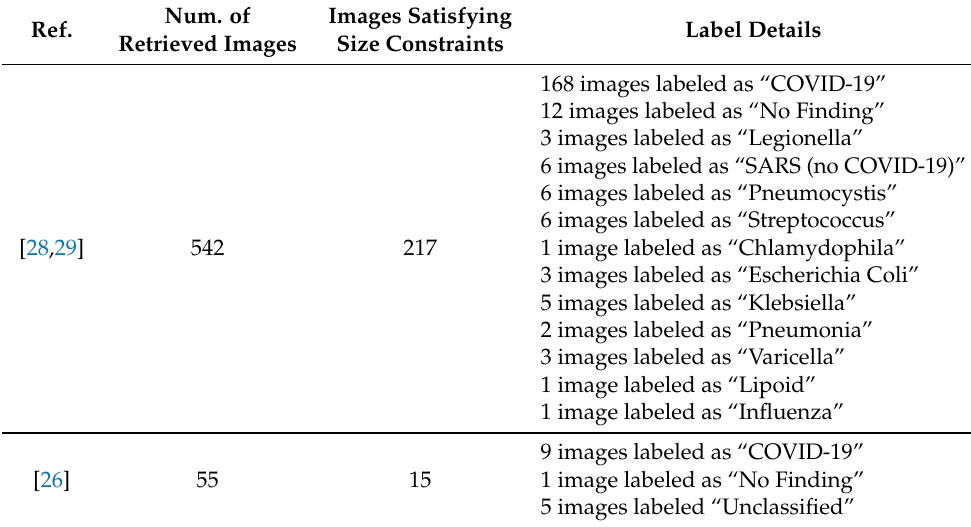
Table 1. Labels of the collected images and sample